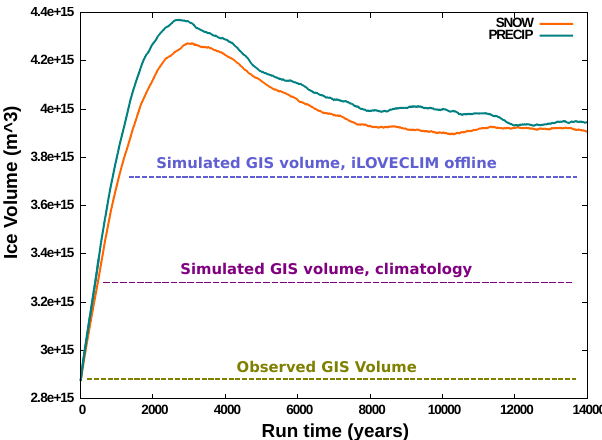
Figure 8. Transient equilibration of the equilibrium runs SNOW and PRECIP: vertical axis is ice volume, horizontal axis is sim- ulation years. For comparison, horizontal dashed lines mark the equilibrium ice volume obtained from observations (Bamber et al., 2001), simulated in the offline simulation forced by the climatol- ogy and using the control climatic fields from i LOVECLIM (no ice-sheet